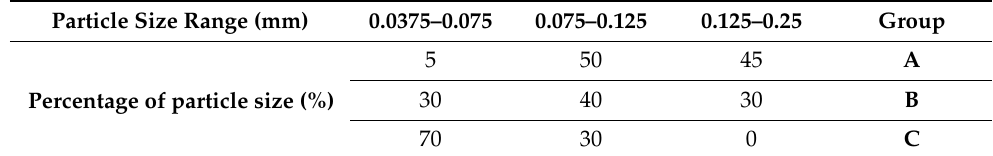
Figure 3. Mineral dust collected on-site in the study area ( a ), mineral dust of different particle sizes after sieving by standard sieves ( b – d ). Table 1. Mineral dust particle size